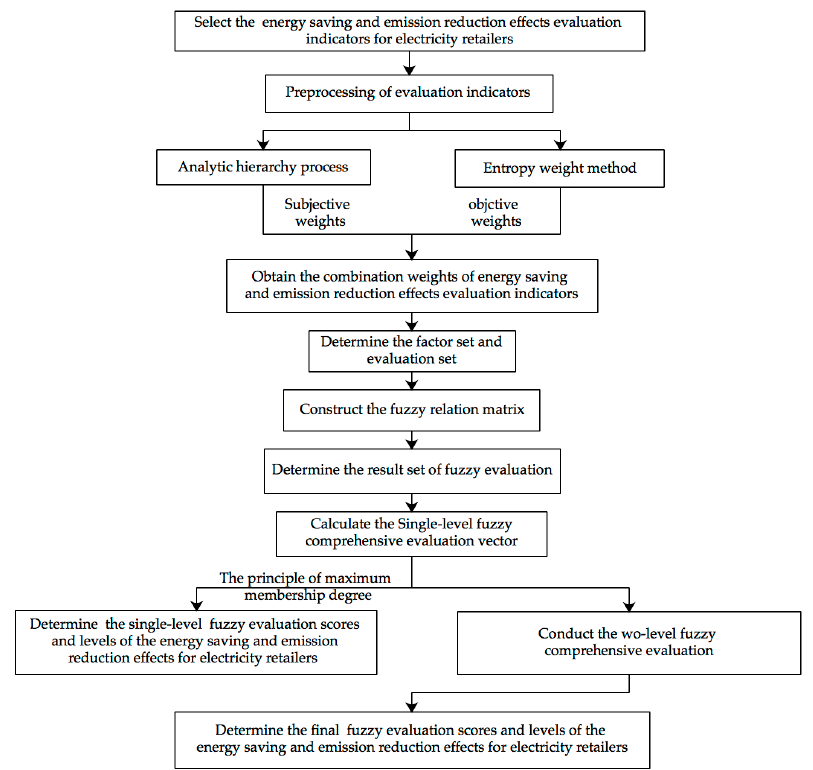
Figure 3. Evaluation process of energy saving and emission reduction effects for electricity retailers.